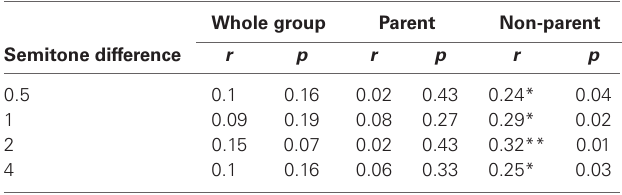
Table 2 | Results of correlation analyses of EQ scores with accuracy of performance on distress detection